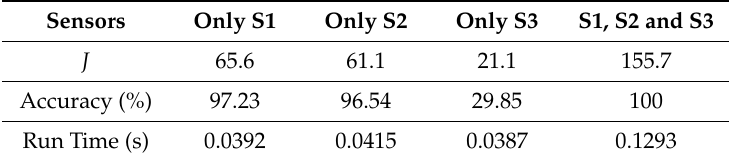
Table 5. The separability J , running time, and accuracy using different sensor fusion methods.